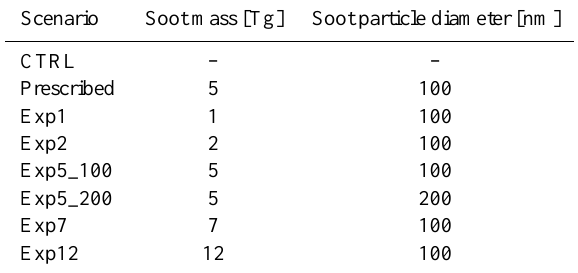
Table 2. Summary of performed model